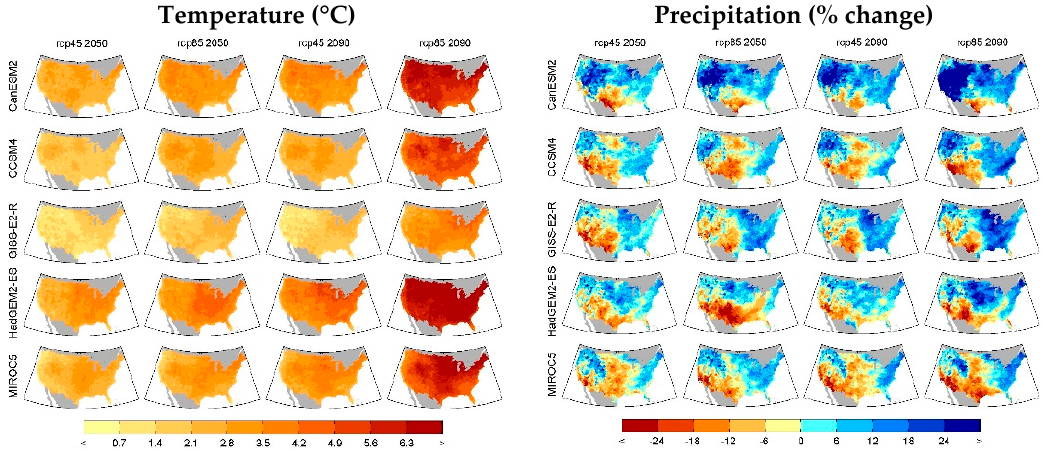
Figure 1. Mean projected changes in temperature (°C; left ) and precipitation (%; right ) for the five climate models, two emissions scenarios, and the 2050 and 2090 eras. Changes are between the average of the 20 ‐ year projected era and the 20 ‐ year baseline.